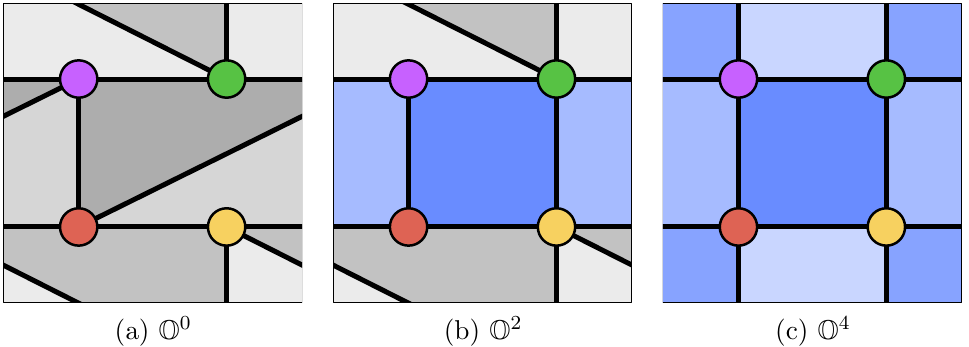
Figure 3 . Four operators (circles) are inserted on a torus (the top and bottom sides as well as the left and right sides of the square are identi(cid:12)ed). Wick contractions organize into skeleton graphs , where each edge (black line) is a bundle of parallel propagators. For our choice of operators, all faces of all skeleton graphs are octagons. Shown in shades of gray are octagons that touch only two or three of the operators, these are protected by supersymmetry. Octagons that touch all four operators (blue shades) are non-trivial functions of the ’t Hooft coupling and conformal cross ratios.